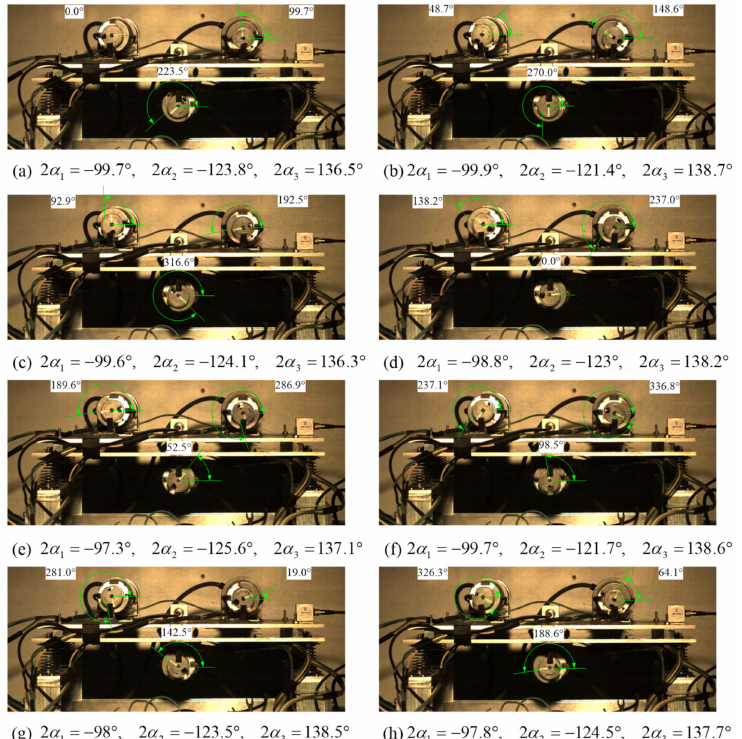
Figure 13. The phase difference of vibration synchronization of three ERs in the anticlockwise rotational direction. ( a – h ) are photos of continuous time intervals of 200